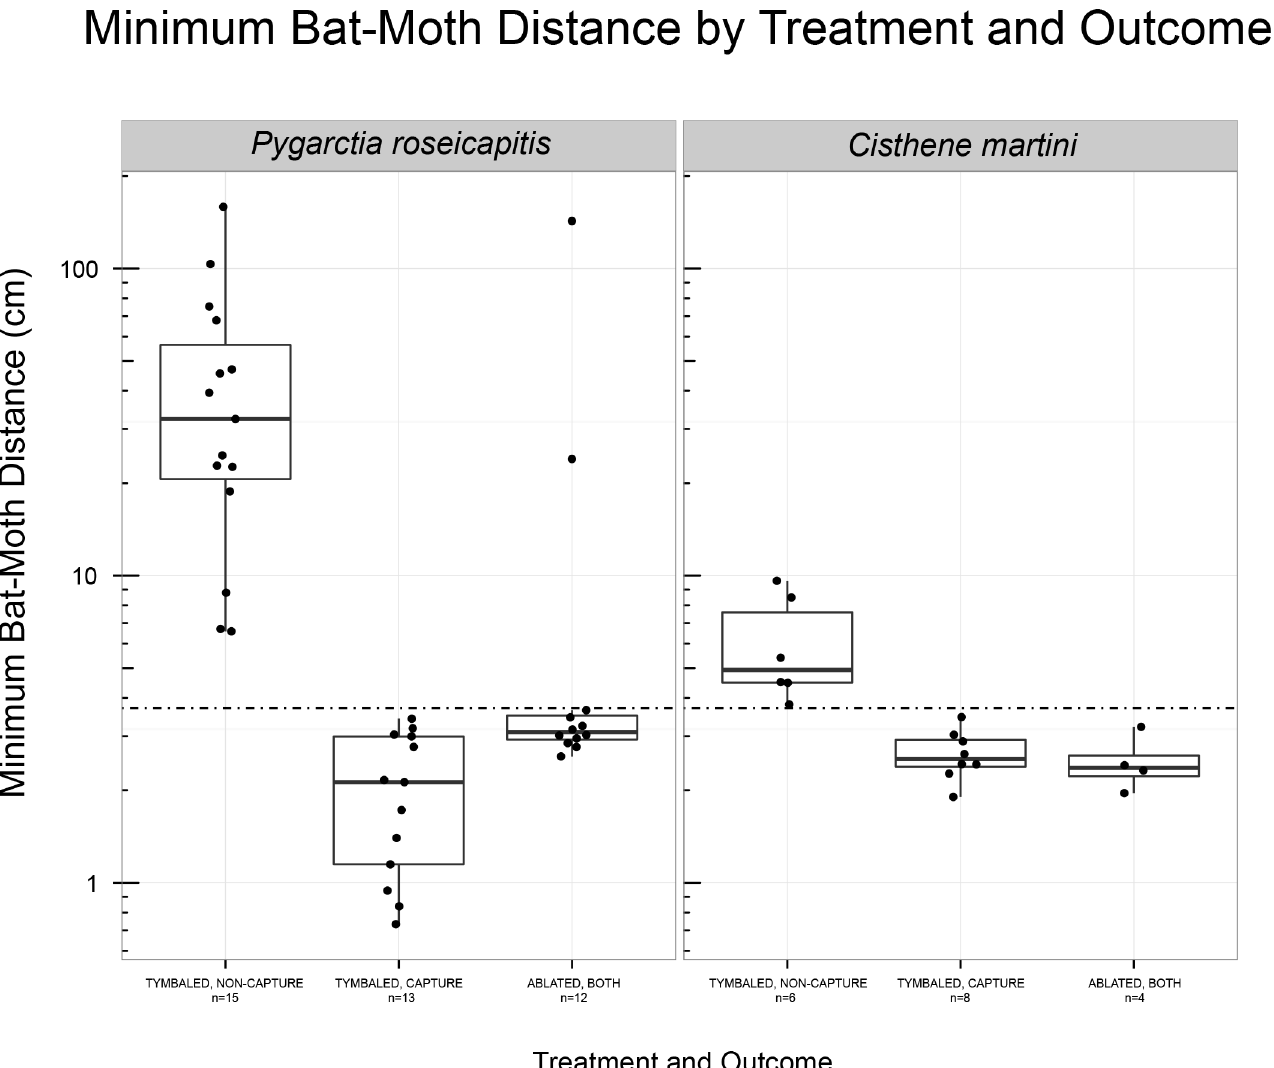
Fig 5. Minimum bat-moth distances (mBMD) between “ Capture, Drop ” and “ Non-Captured ” outcomes among “ Tymbaled ” (T+ and S groups) and “ Ablated ” (T-) moths for Pygarctia roseicapitis and Cisthene martini . Boxplot follows plotting conventions in Fig 3. Horizontal dot-dashed line demarcates 3.7 cm which was the most conservative of the smallest minimum bat-moth distances in which we could measure due to inherent limitations and error in the 3-D reconstruction process. Bat and moth should be considered to be occupying the same coordinates below this value. This plot displays the closest distance between bats and moths (T+ and S treatments) during each interaction. Interactions that resulted in “ Capture, Drop ” were all below 3.7 cm. All interactions that resulted in “ Non-Capture ” were above 3.7